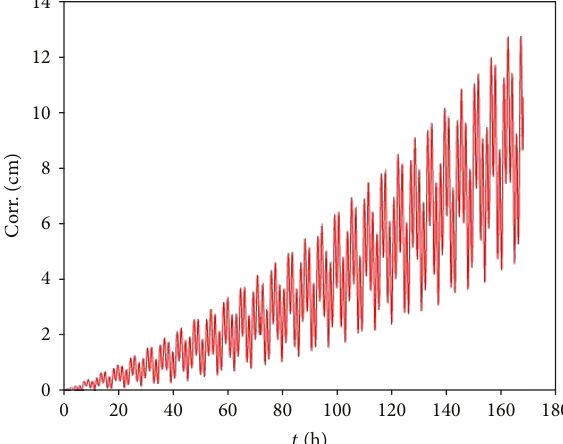
Figure 5: Total p-N corrections versus time with TOL TOL =10 − 13 a